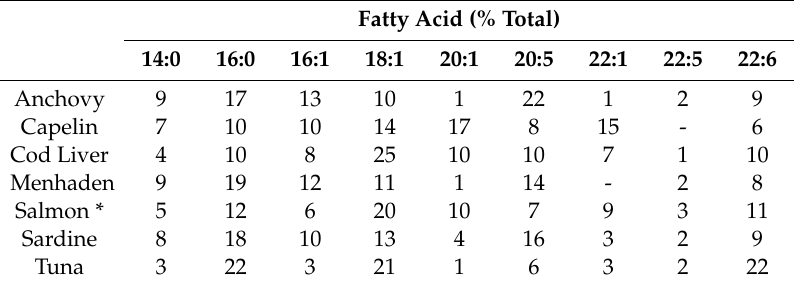
Table 1. Comparison of the fatty acid composition of some commercial fish